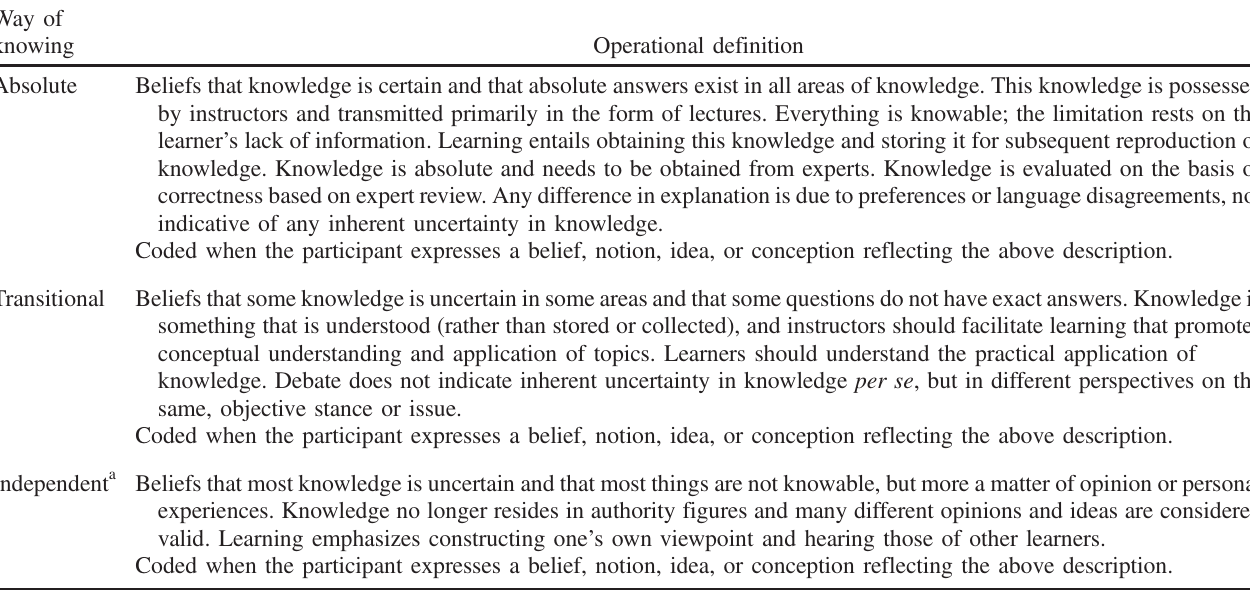
TABLE V. Overview of the different ways of knowing described in the epistemological reflection